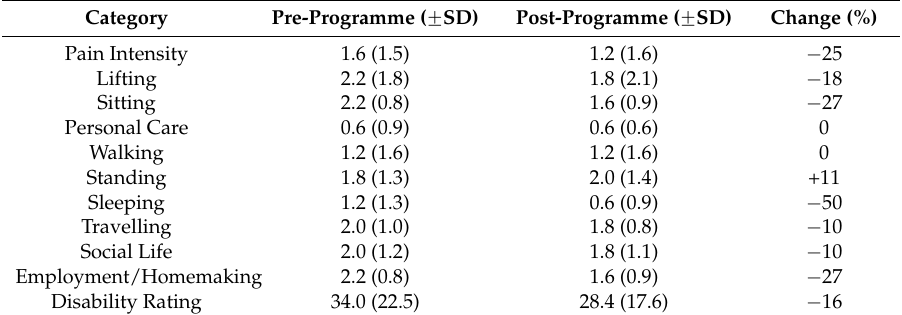
Table 2. Pre-post programme Modified Oswestry Low Back Pain Disability (MODQ) scores (± SD) and percentage changes.